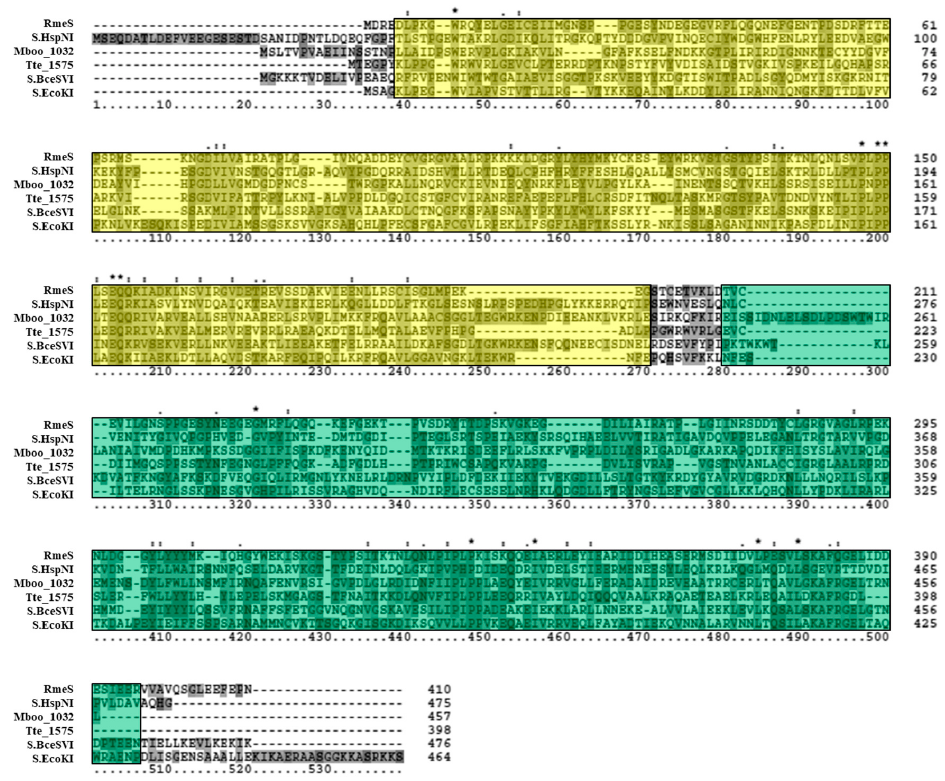
Figure 5. Amino acid alignment of RmeS homologs. The multiple sequence alignment includes RmeS ( Haloferax volcanii DS2; GenBank ADE04051), S.HspNI ( Halobacterium salinarum NRC-1; GenBank AAG18734), Mboo_1032 ( Methanoregula boonei 6A8; ABS55550), Tte1545 ( Caldanaerobacter subterraneus subsp. tengcongensis MB4; GenBank AAM24754), S.BceSVI ( Bacillus cereus ATCC 10987; GenBank AAS39773), and S.EcoKI ( Escherichia coli K-12; GenBank AAG18734). The first SCOP